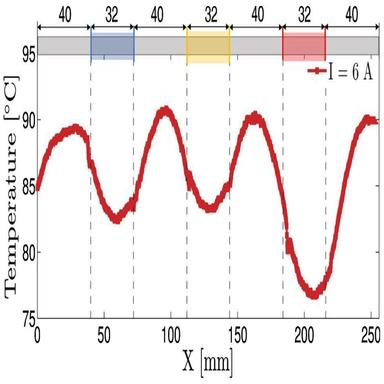
Temperature profile of the FGM produced (Strip 1) using the methodology described in section. The electrical conductivity changes along the produced FGM and this implies different heat generation zones when an electrical current flow through the material.